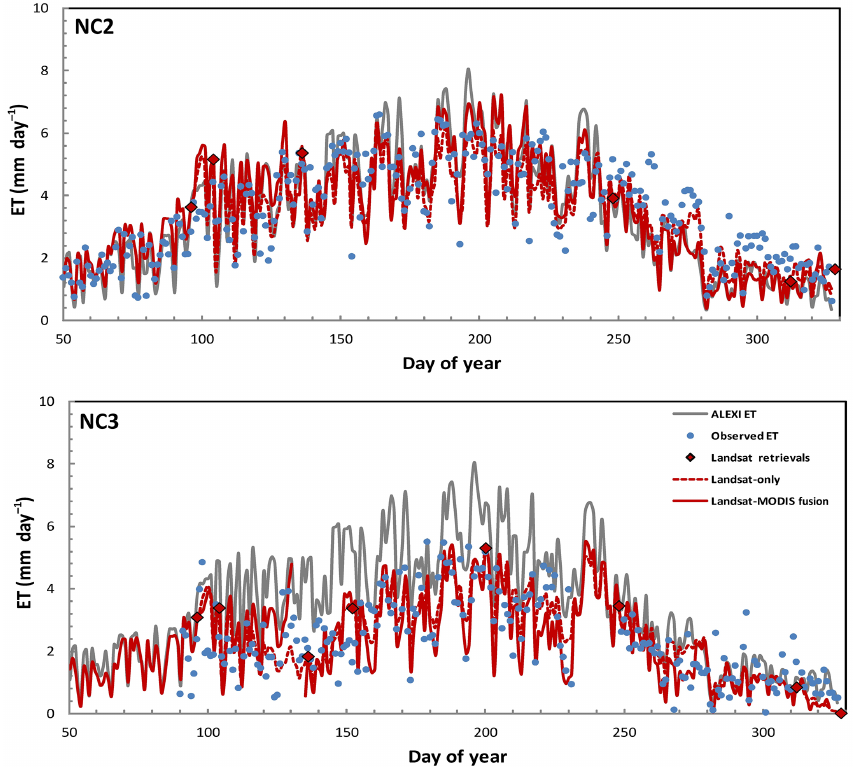
Figure 8. Comparison of time series of ALEXI ET (4km), observed ET, Landsat ET retrieved on Landsat overpass dates, Landsat-only interpolated ET and Landsat–MODIS fused ET for the NC2 site (and NC3, bottom panel) sites in